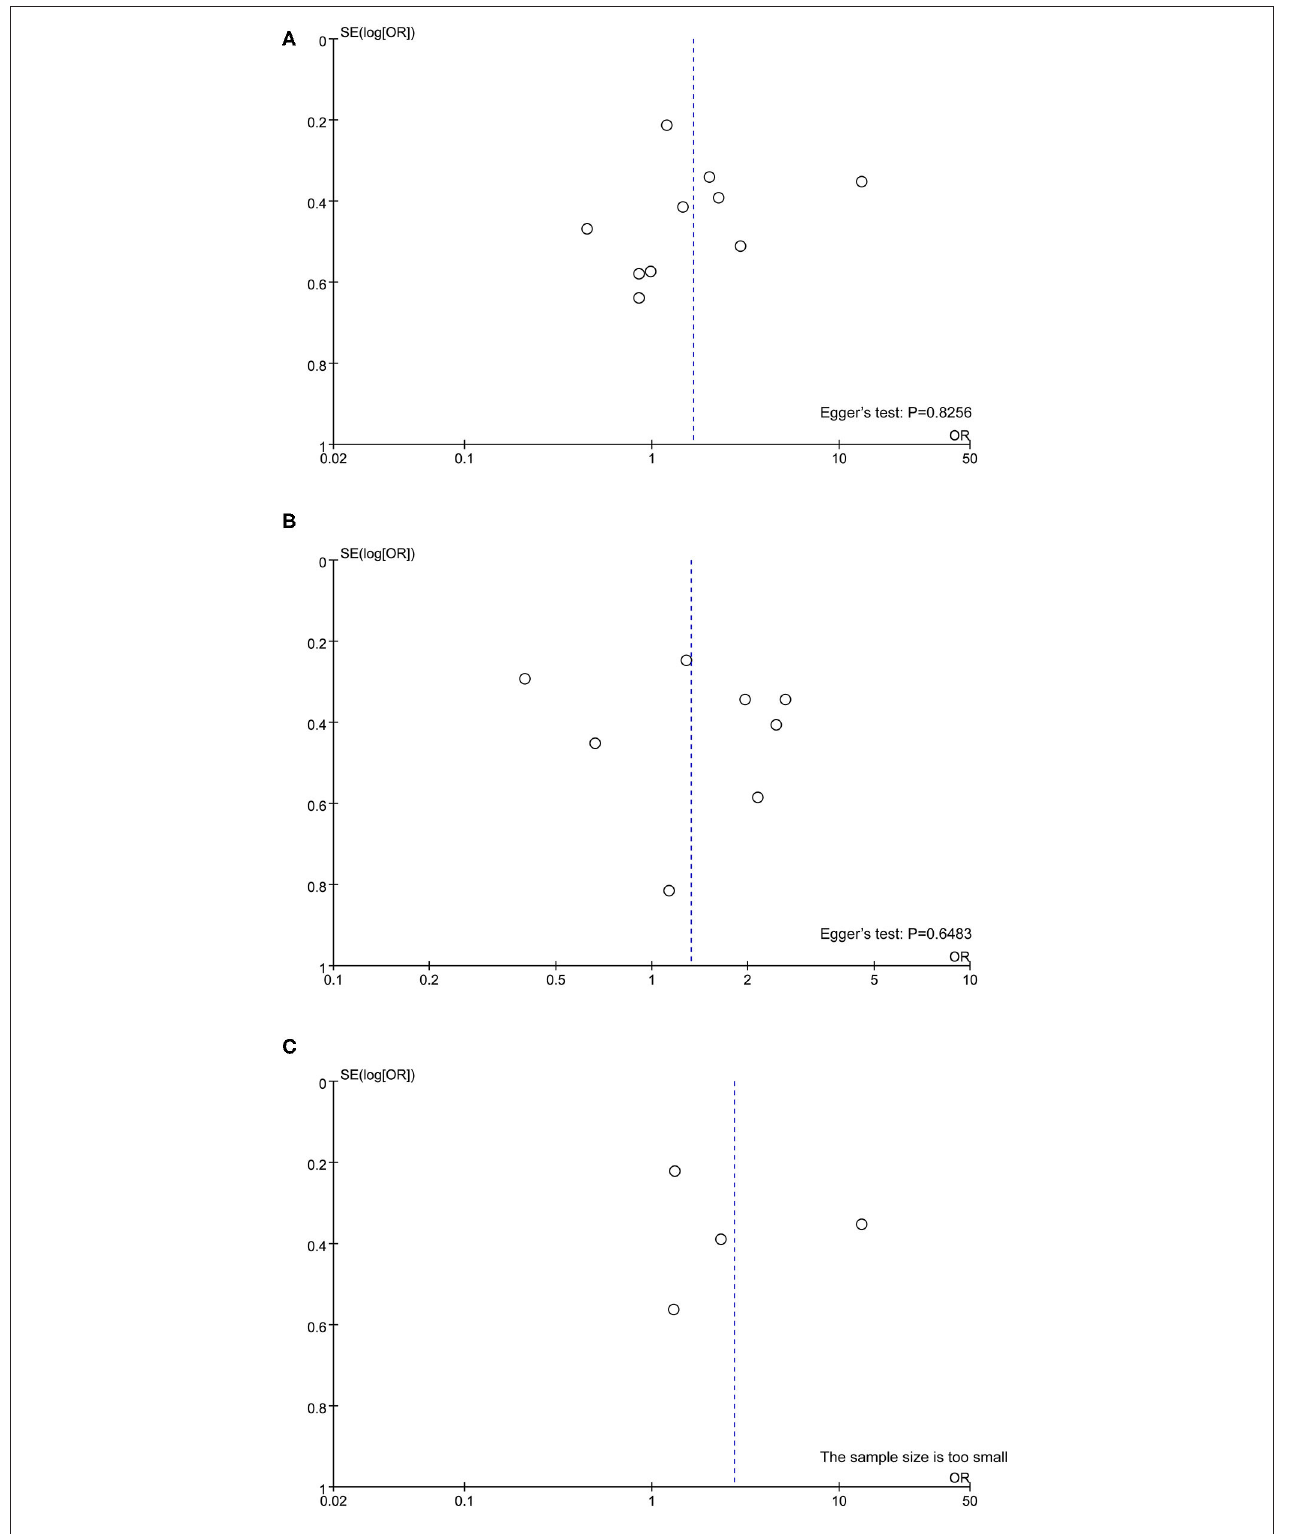
FIGURE 2 | Publication bias assessed by funnel plot and Egger’s test. (A) rs12979860; (B) rs8099917; (C) rs12980275.